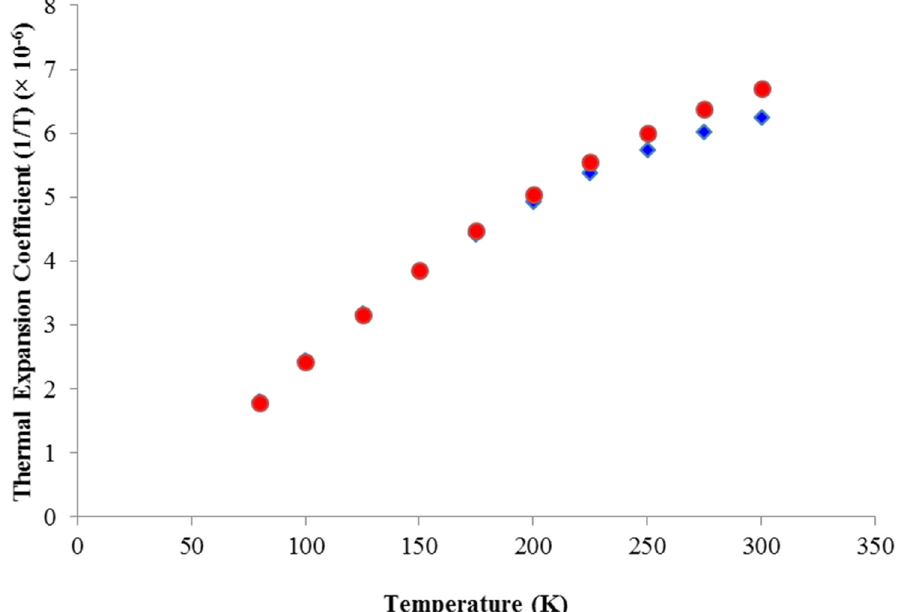
Figure 23. Thermal expansion coefficient as a function of absolute temperature for the biaxial laser material YSO (blue) [30] and the isotropic laser material GSAG (red) [30]. YSO data is reported for the b -axis, and all data are for undoped crystals.